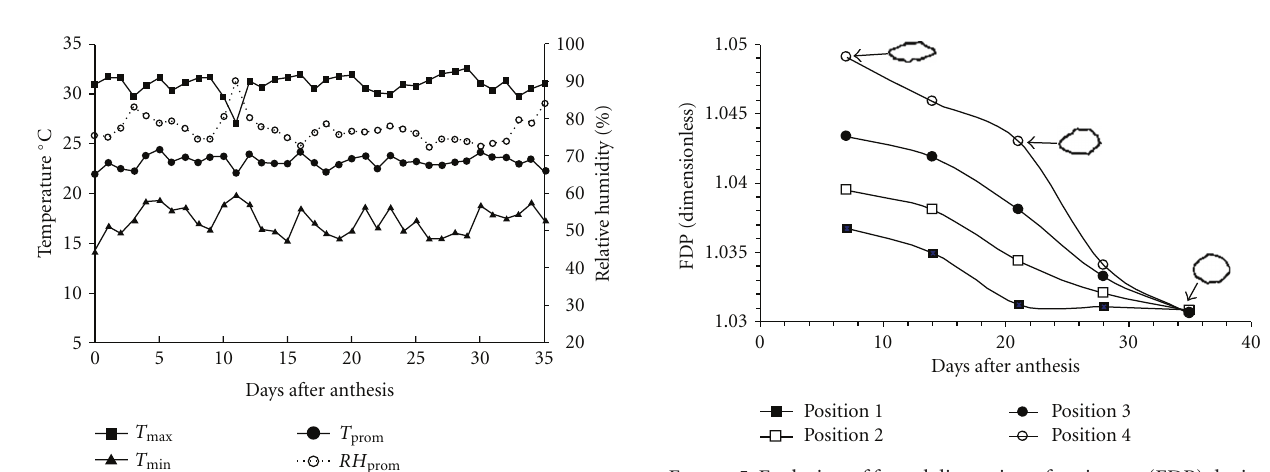
Figure 5: Evolution of fractal dimension of perimeter (FDP) during grain filling and maturation of rice Morelos A-98. Objects represent contour (perimeter) binarized of OM (3X) micrograph of grain transversal cut.